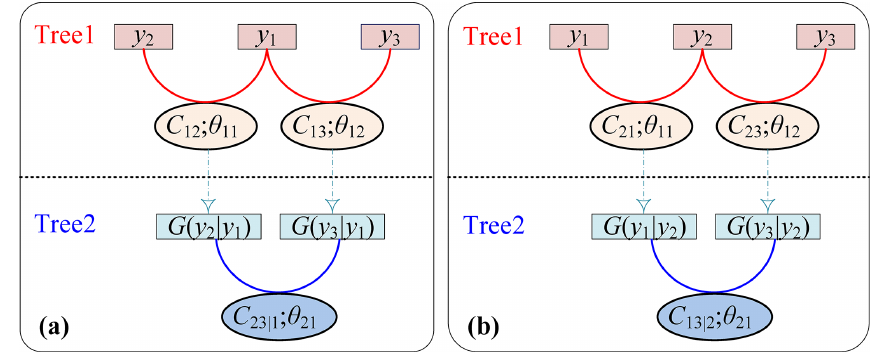
Figure 2. Different schematics (two types) for C-vine copulas using three-dimensional scenarios. For the first type (a) , the ordering variables are y 1 , y 2 , and y 3 ; for the second type (b) , they are y 2 , y 1 , and y 3 . C 12 (C 21 ) , C 13 (C 23 ) , and C 23 | 1 (C 13 | 2 ) denote bivariate copulas with parameters of θ 11 , θ 12 , and θ 21 , respectively. Here, θ ij signifies the parameters of the j th edge with respect to the i th tree. G ( ·|· ) represents conditional distribution